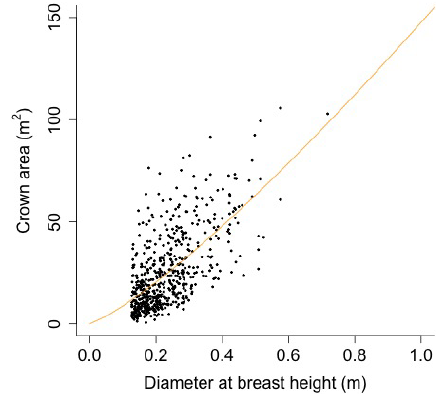
Figure D10. Crown area model fit to FIA Forest Health Monitoring data for Acer